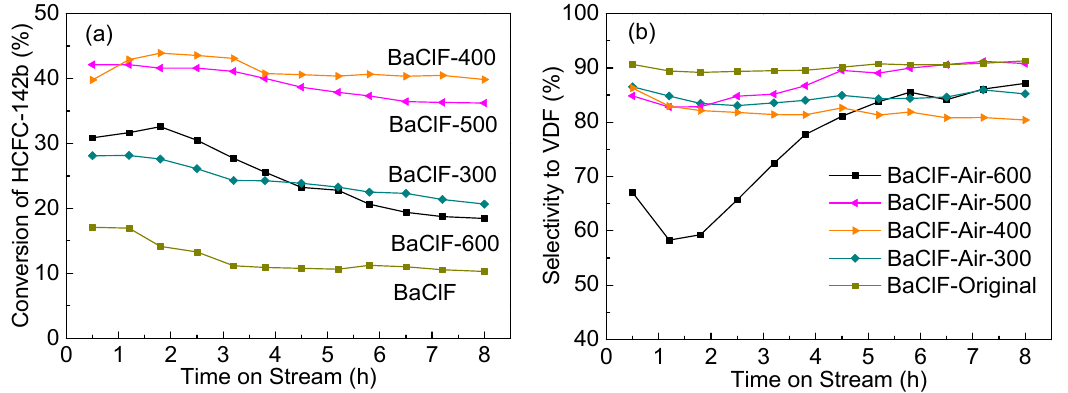
Figure 7. Effect of calcination on the conversion of ( a ) HCFC-142b and ( b ) selectivity to VDF for BaClF catalysts.